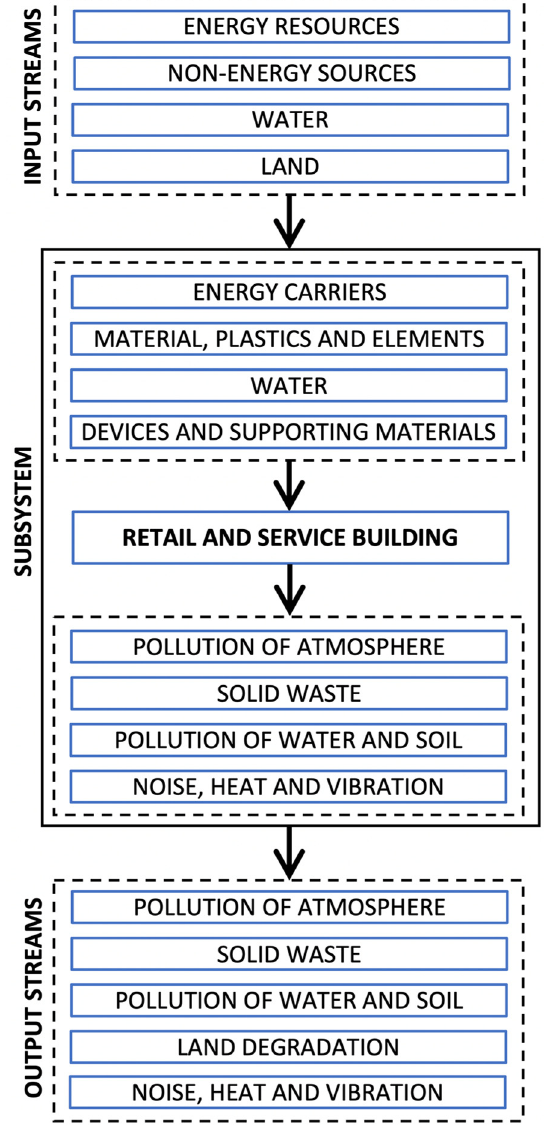
Figure 1. Diagram presenting a commercial and service building as a subsystem in an ecosystem with flow streams. Own elaboration based on [15].